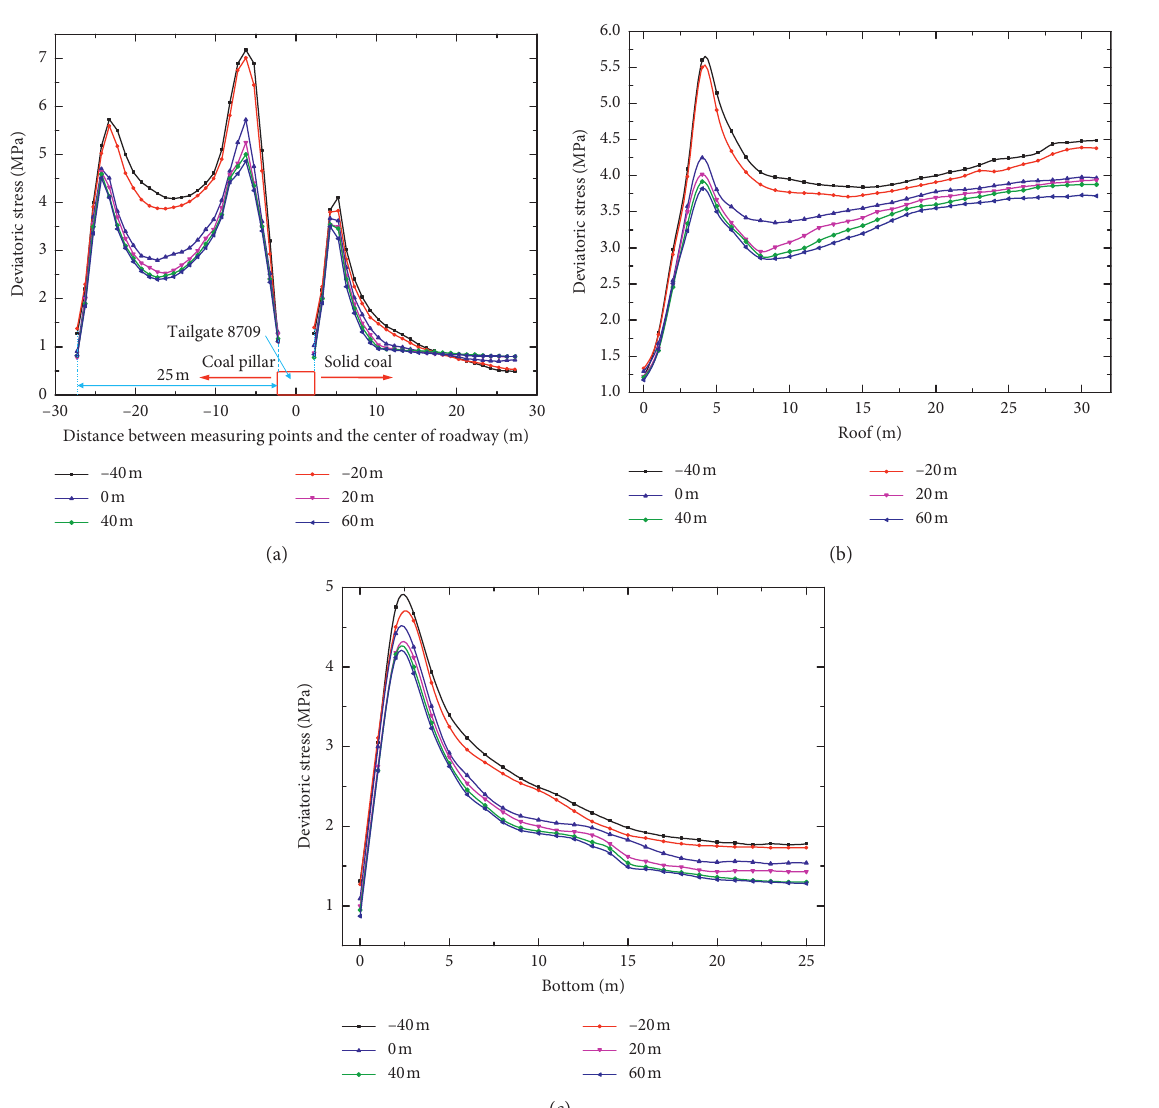
Figure 7: Deviatoric stress curves of Tailgate 8709 in the mining process of the N8707 coal face in No. 11 coal seam: (a) deviatoric stress curves in coal pillar and solid-coal side; (b) deviatoric stress curves of the roof; (c) deviatoric stress curves of the